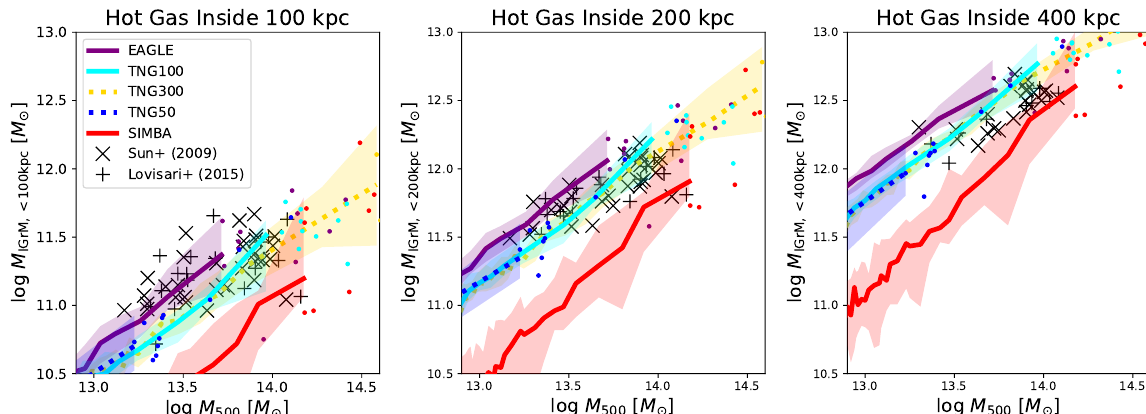
Figure 4. IGrM masses (gas at T 10 6 K) within three fixed 3D apertures plotted for EAGLE (purple), SIMBA (red), and all ≥ three IllustrisTNG volumes (dark blue, cyan, and yellow). Medians and 1 σ scatter are indicated by lines (dotted for TNG50 and TNG300, solid for others) and shaded regions, respectively. Different panels correspond to limiting radii of 100 kpc ( left ), 200 kpc ( middle ), and 400 kpc ( right ). Observed IGrM masses of individual groups within these radii, obtained from the (3D) profiles of Sun et al. [2] and Lovisari et al. [5], are shown as black symbols. While differences between simulations are approximately consistent across the three limiting radii, the agreement with observations differs noticeably between the group center (left-hand panel) and outskirts (right-hand